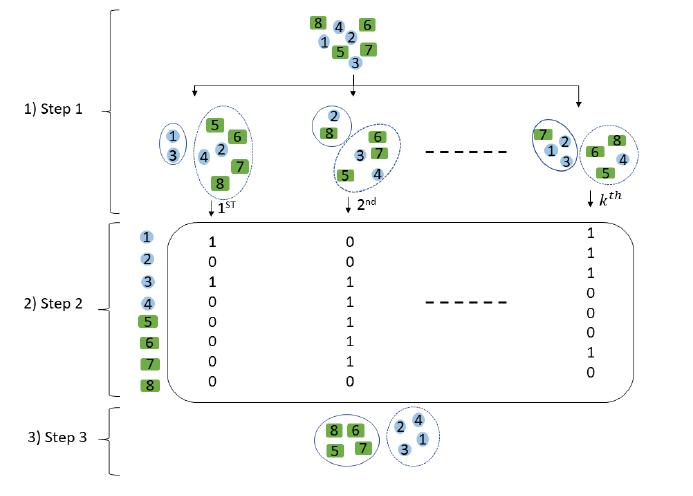
Figure 3. Illustration of the binary clustering algorithm, which is applied to each node of the tree. Step 1 is to cluster the data into binary clusters, and it is iterated k times. Step 2 is to build a binary matrix (BM) by stacking all the k binary clustering results. Step 3 is to use an entropy-based ensemble algorithm to split the parental node into two child nodes by using the information of the